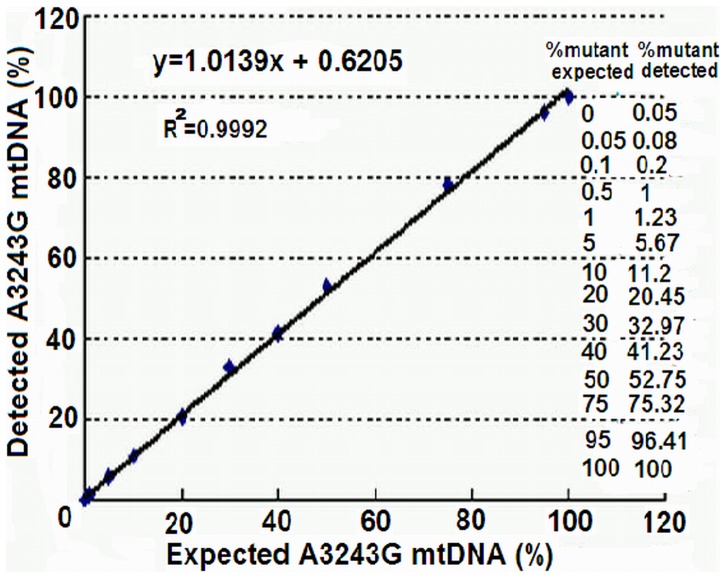
Accuracy of the qPCR for the measurement of wild-type mtDNA and A3243G mutant mtDNA.Copy number standards of wild-type mtDNA and A3243G mutant mtDNA were mixed in defined ratios and to a total copy number of 106, and then subjected to qPCR to measure the ratios of A3243G mutant mtDNA. Results fit the expected ratios closely. Experiments were done in triplicate.